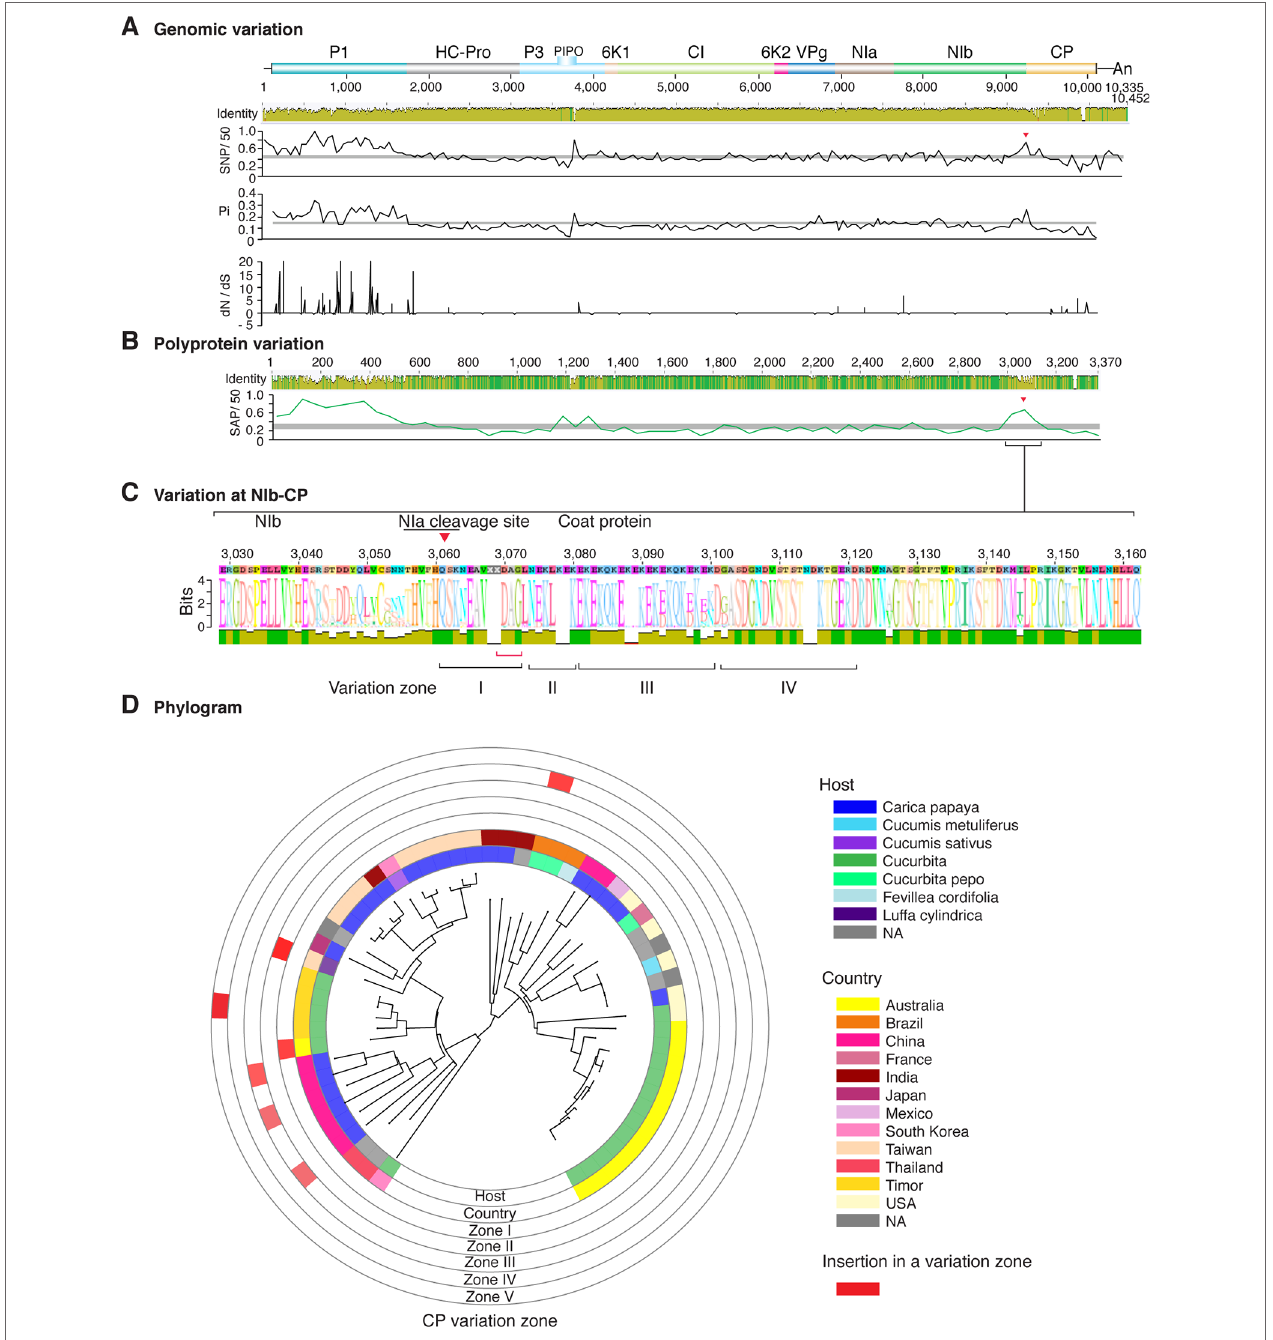
FiGUre 6 | Nucleotide and polyprotein variation in papaya ringspot virus. Genome organization is shown to scale using accession KP462721.1 as reference. Labels are as in Figure 2 .